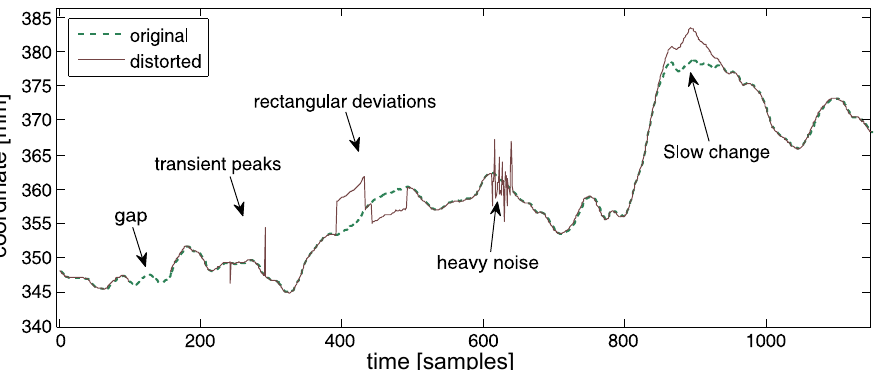
Figure 2. Identified types of distortions inpainted into exemplary data—the first coordinate of the first marker (head) of the IM